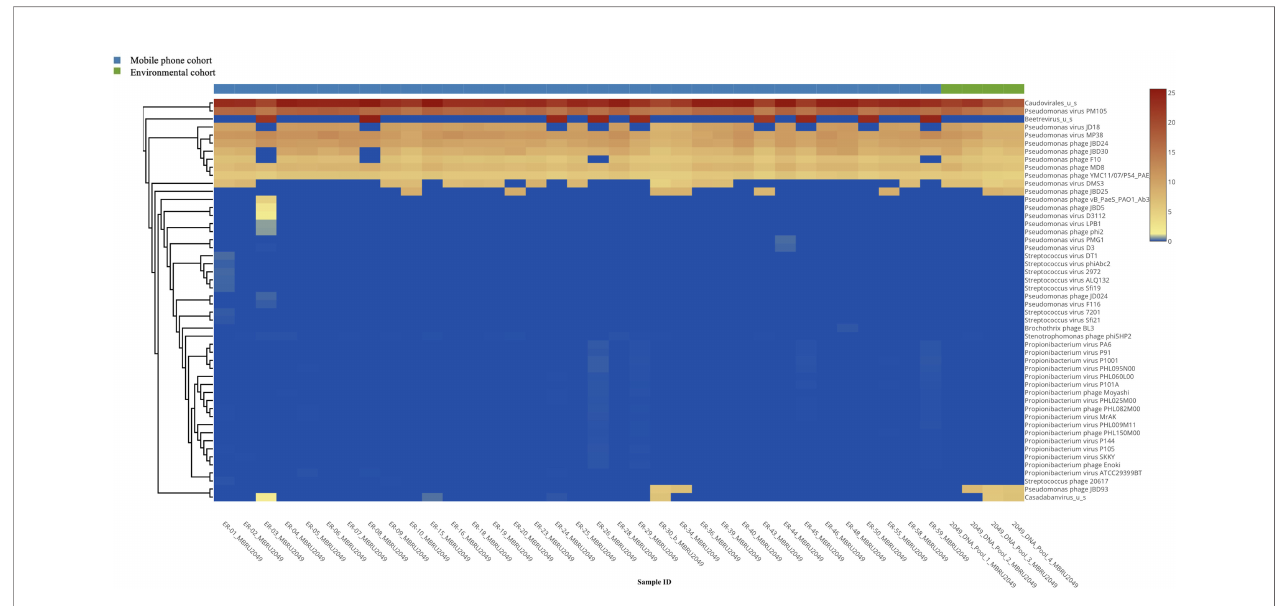
FIGURE 2 | Heatmap of the bacteriophage distribution.